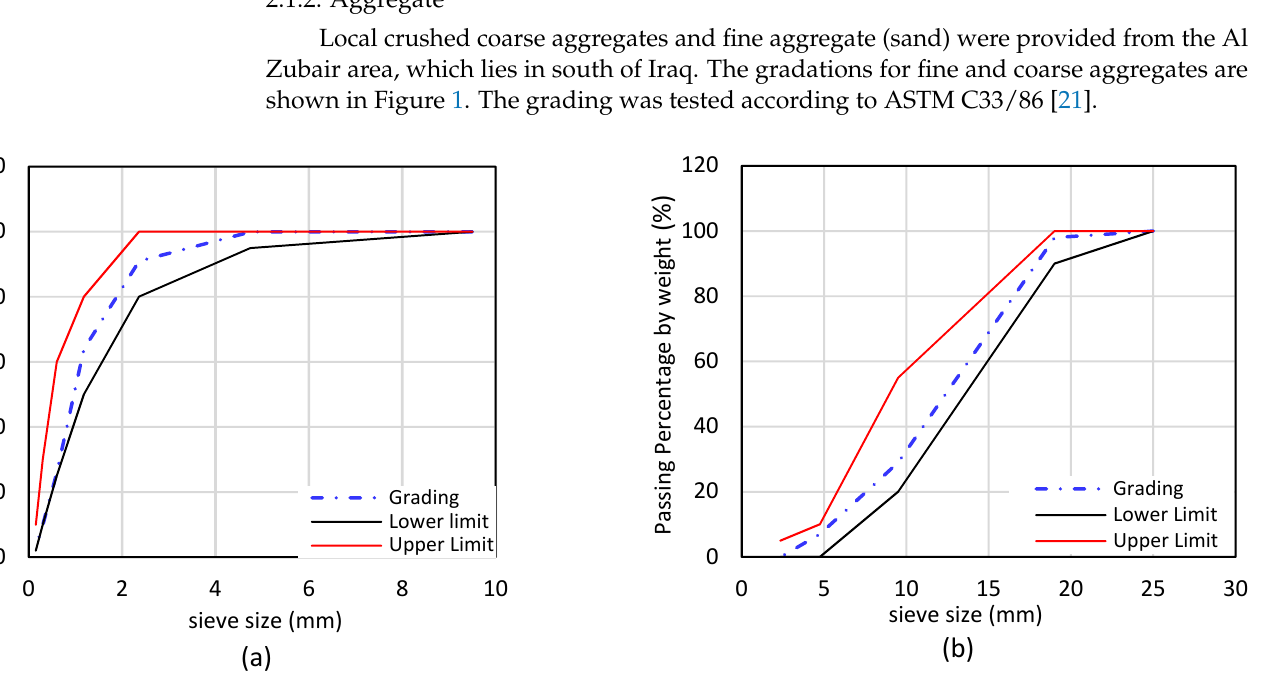
Figure 1. Aggregate grading as: ( a ) Fine aggregate grading; ( b ) Coarse aggregate grading.